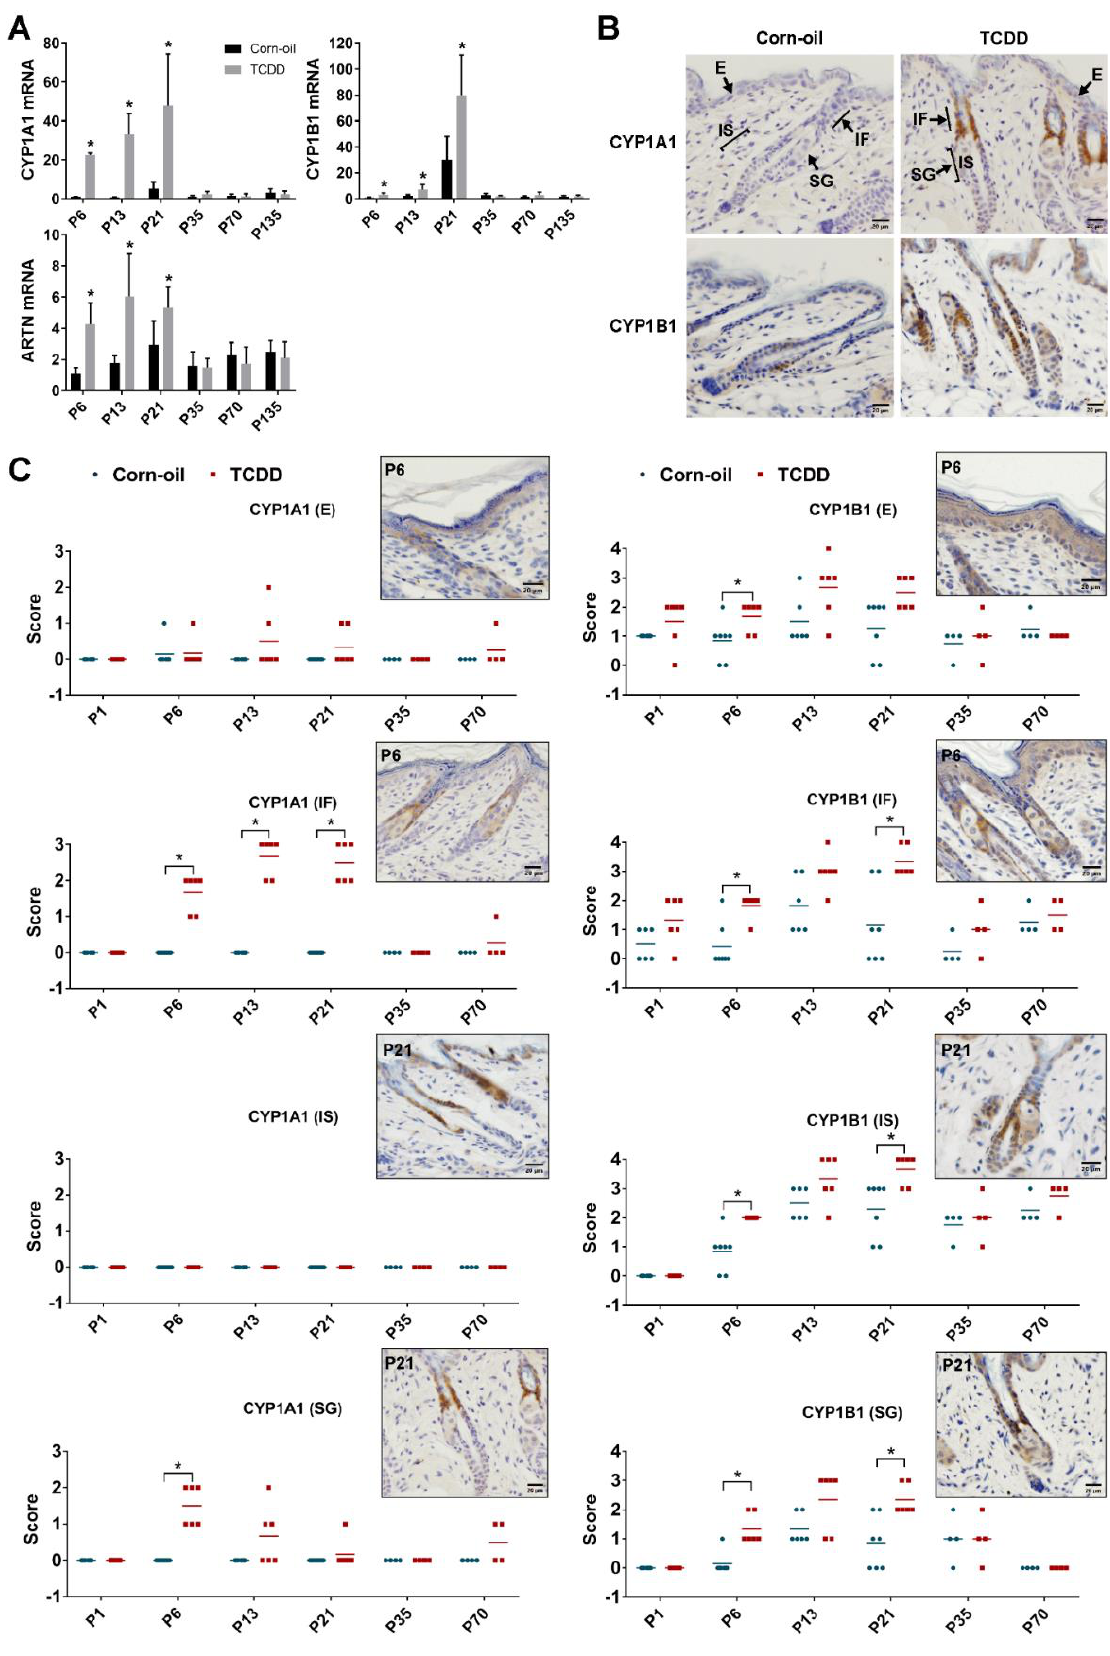
Figure 4. Biomarkers of response to TCDD. Time-mated mice were treated by gavage with either corn-oil or TCDD (5 μg /kg bw) and pups were analyzed for biomarkers of AHR activation. ( A ) Murine skin Cyp1a1 , Cyp1b1 , Artn mRNA ex- pression measured by qPCR at the indicated age ( n = 4 – 6). Data were analyzed by two- tailed Student’s t -test. * p < 0.05,